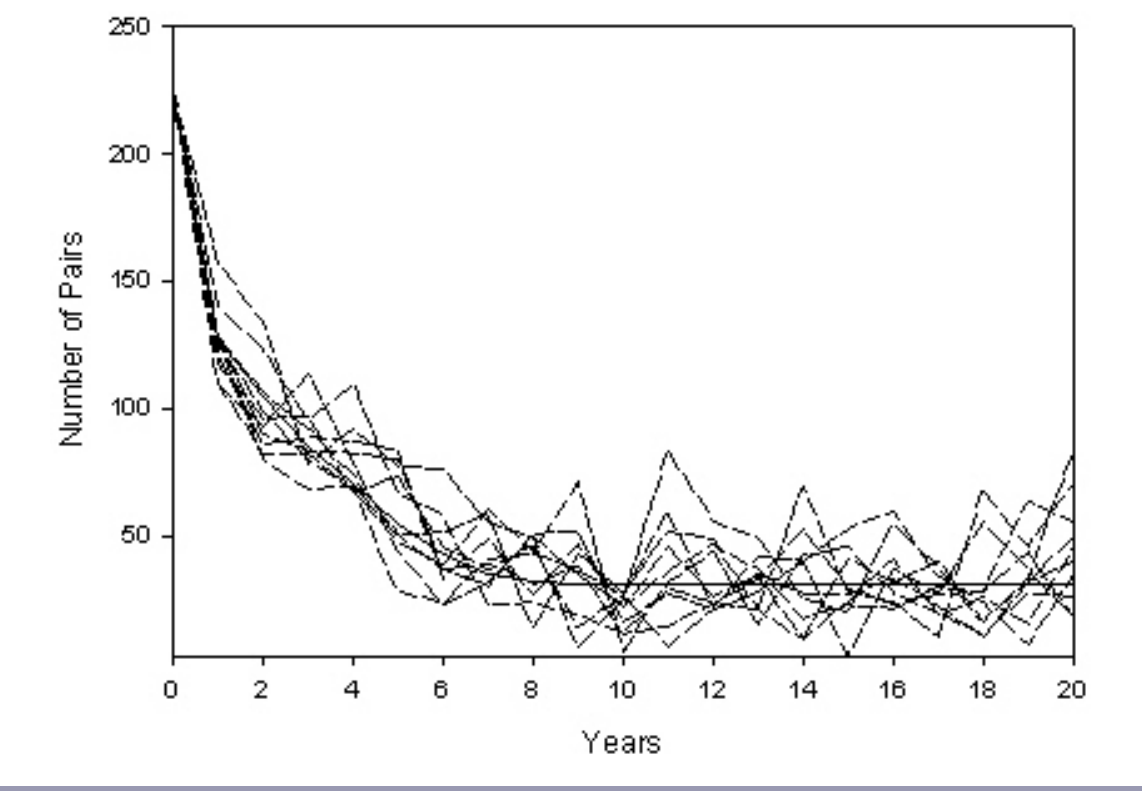
Fig. 4. Simulation results for the overall population size of 24 Ivory Gull colonies on Ellesmere Island and Devon Island. Dashed lines indicate 10 individual runs of the model; the solid line is the mean of 5000